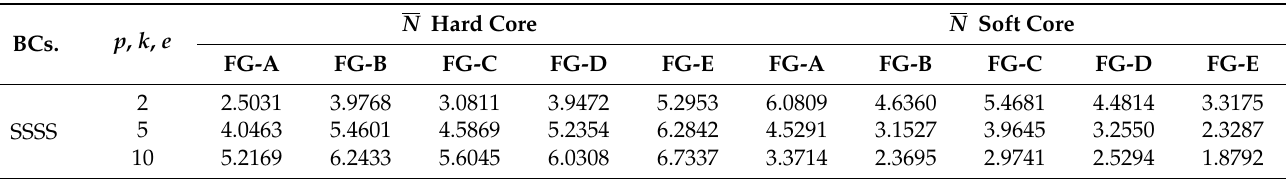
Table 6. Dimensionless critical buckling load N of FG shells for various boundary conditions